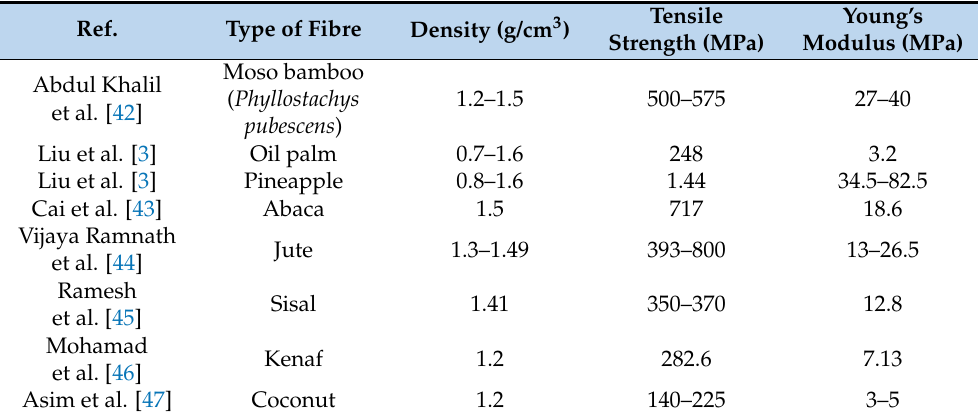
Table 2. Summary of mechanical and physical properties of natural plant fibres.